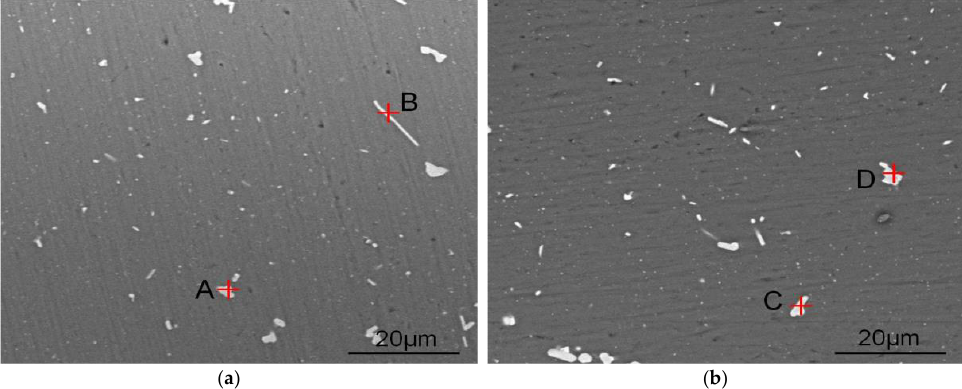
Figure 6. Scanning electron microscopy (SEM) images of aged alloys with Fe contents: ( a ) 0.10 wt.% and ( b ) 0.20 wt.%.